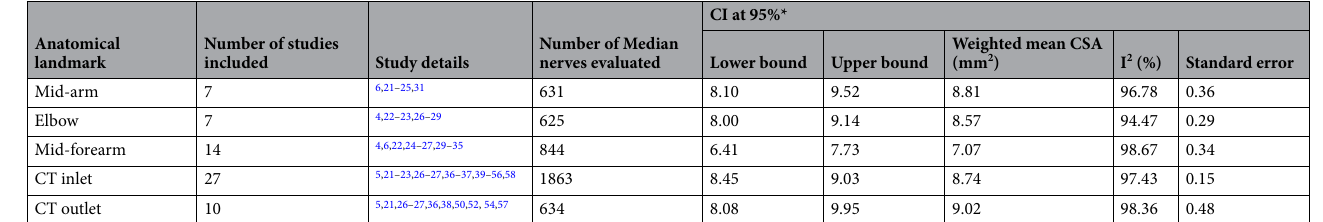
Table 1. Summary of pooled weighted mean of median nerve CSA reported based on anatomical landmarks of the upper limb. Total number of included studies were 41. CSA = cross sectional area. CI = confidence intervals. *Heterogeneity (I 2 ) P values of Cochran Q statistic is P < 0.001 in all landmarks, except Mid-arm with P < 0.01.